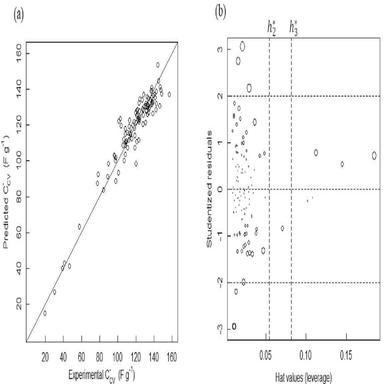
Experimental values vs. predicted gravimetric capacitance (a) and model diagnostic plot (b) corresponding to Eq..